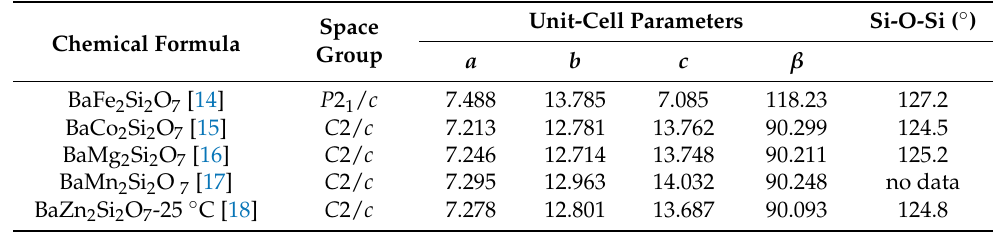
Table 5. The crystal structure of some BaM 2 Si 2 O 7 -type minerals with the monoclinic system. Chemical